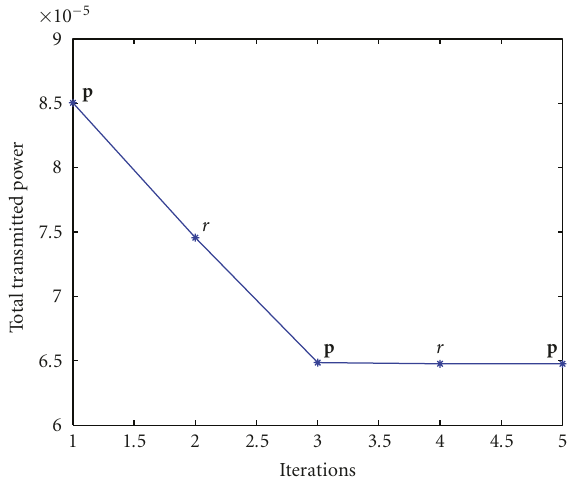
Figure 8: Distribution of powers for the minimal energy